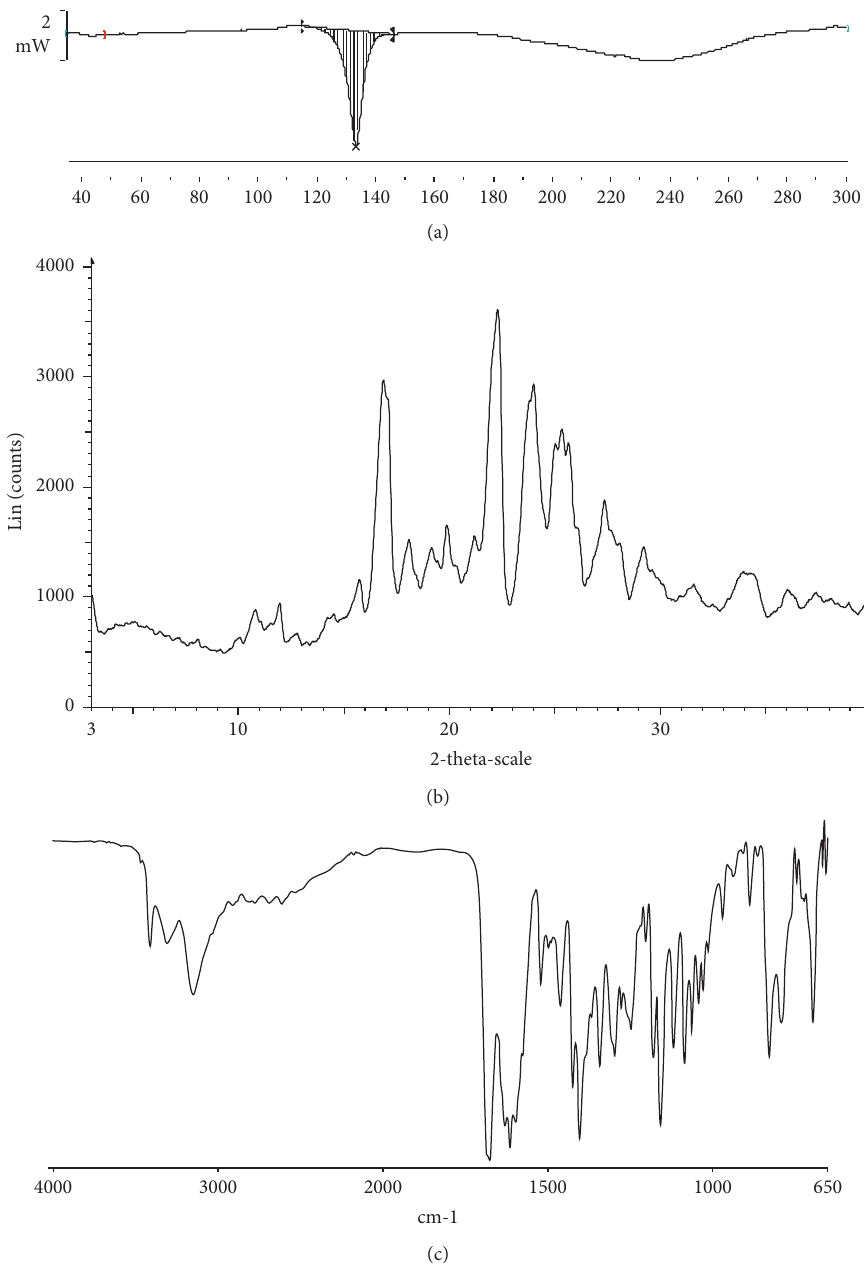
Figure 3: The spectrum of NAR-NCT: (a) DSC, (b) XRPD, and (c)